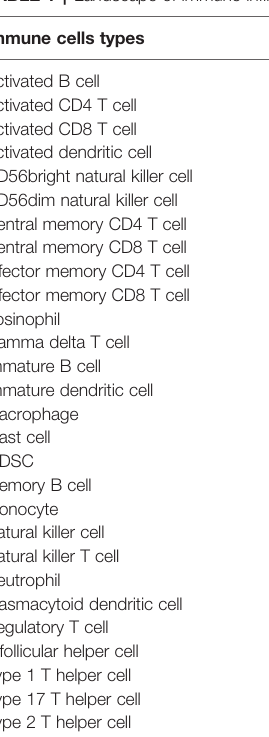
TABLE 1 | Landscape of immune in fi ltration in Crohn ’ s